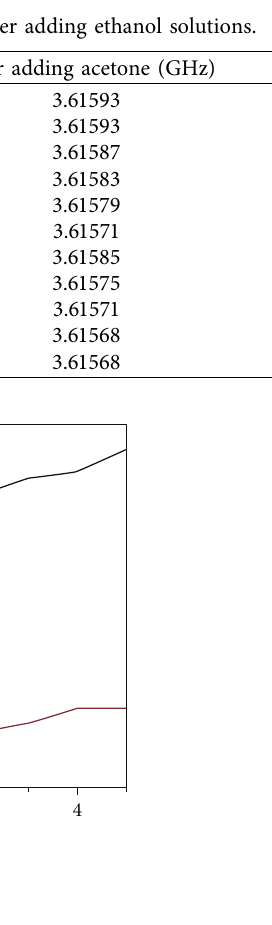
Figure 14: Te fgure for infuence of gate voltage change on the resonance frequency shift value during ethanol experiment. Te black curve f 1 stands for the resonance frequency before ethanol addition, the red curve f 2 stands for the resonance frequency after ethanol addition.